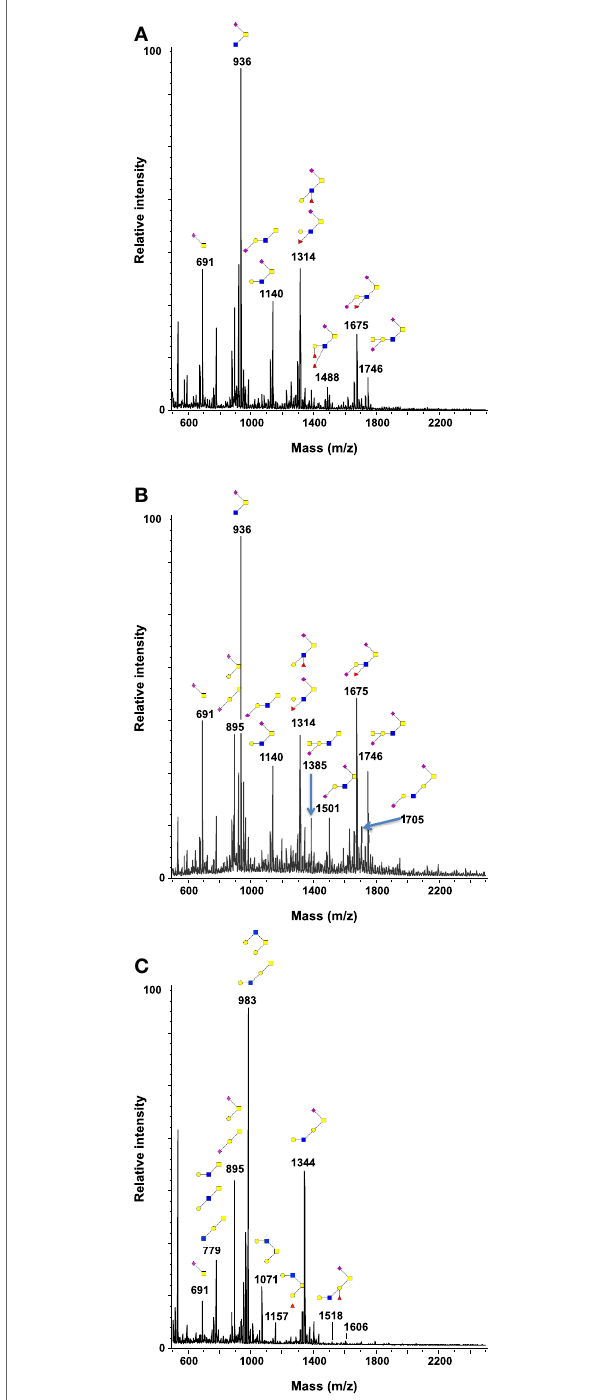
FigUre 1 | structural characterization of human colorectal mucins O-glycans . MALDI-MS spectra, acquired in the positive ion mode [M + Na] + (or [M + 2Na-H] + for sulfated species), of human intestinal permethylated O-glycans from mucins purified from (a) healthy colon controls; (B) resection margins; (c) paired tumoral tissue. Monosaccharide symbols according to the Consortium for Functional Glycomics (CFG) nomenclature. Key: fucose (red triangle), GlcNAc (blue square), sialic acid (purple diamond), galactose (yellow circle), GalNAcol (yellow square), and sulfate residue